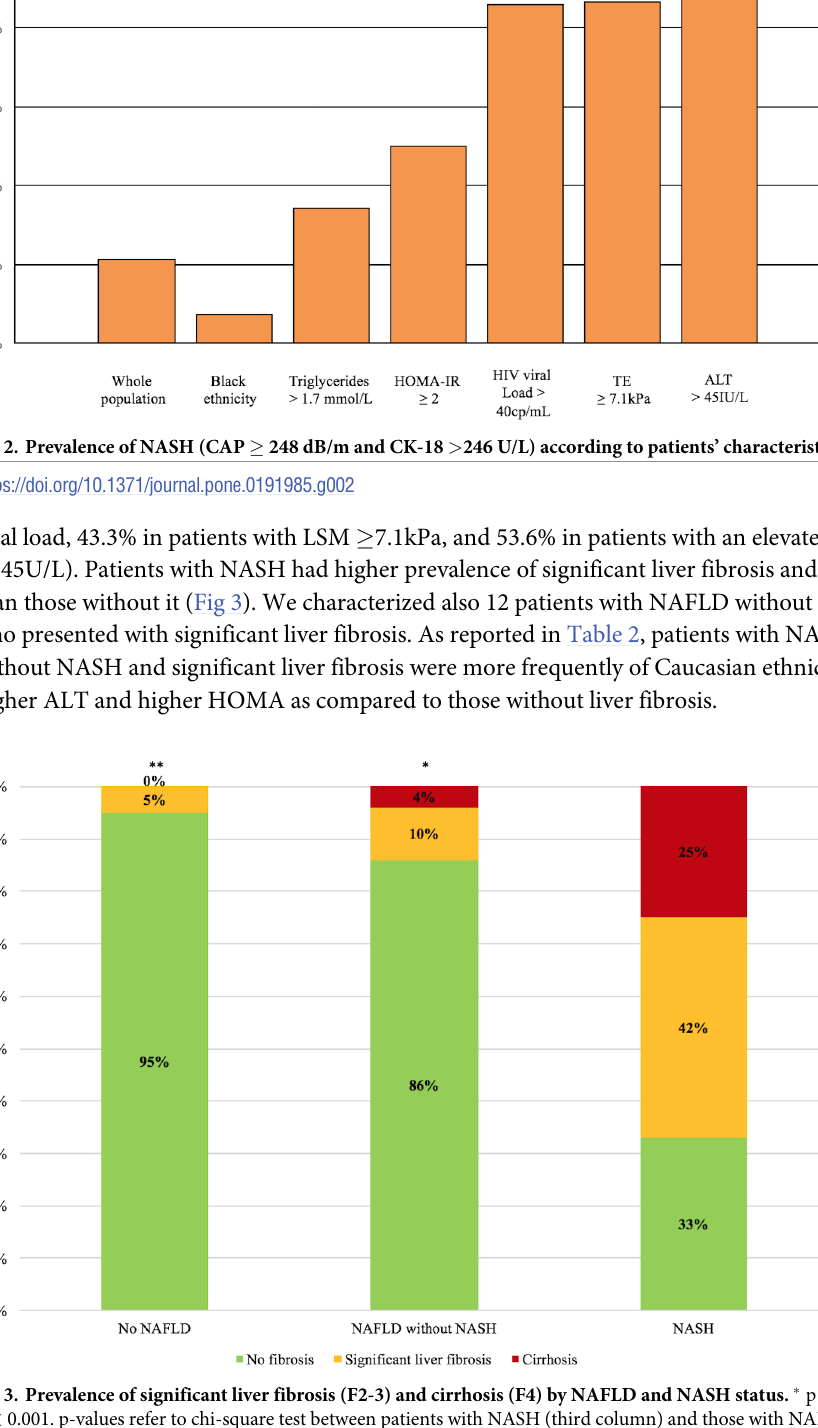
Fig 3. Prevalence of significant liver fibrosis (F2-3) and cirrhosis (F4) by NAFLD and NASH status. (cid:3) p < 0.05; (cid:3)(cid:3) p < 0.001. p-values refer to chi-square test between patients with NASH (third column) and those with NAFLD but without NASH (second column) or those with no NAFLD (first column) and are considered significant when <